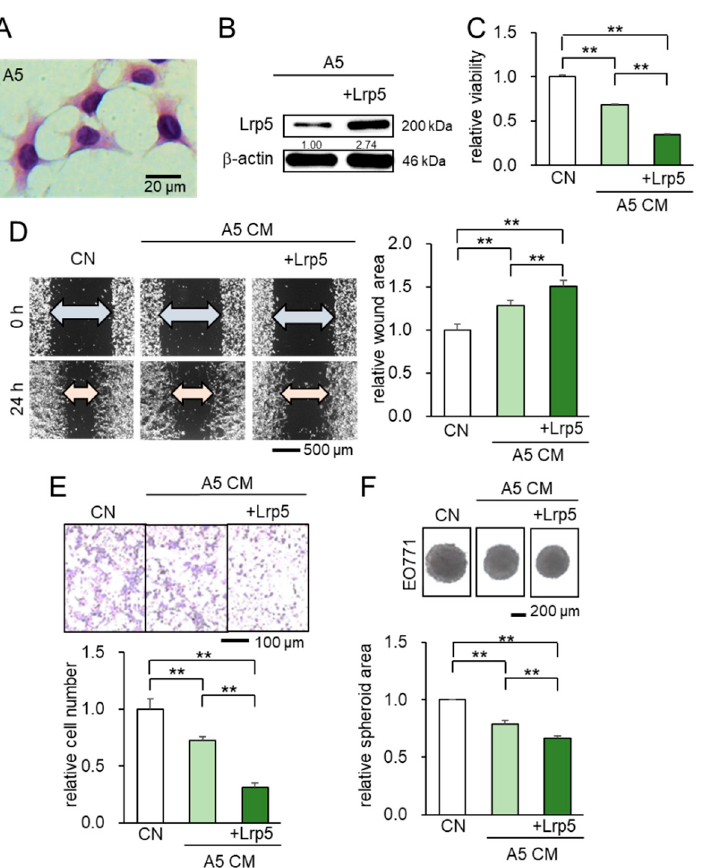
Figure 1. Suppression of the cellular proliferation, invasion, and migration in EO771 tumor cells by osteocyte-derived CM with and without Lrp5 overexpression. Of note, CN = control and CM = conditioned medium. The double asterisk indicates p < 0.01. The error bar indicates a standard deviation. ( A ) Representative images of MLO-A5 osteocytes (hematoxylin stained). ( B ) Transfection of Lrp5 plasmids in A5 osteocytes. ( C – E ) Reduction in MTT-based cellular viability, scratch-based migration, and Transwell invasion by osteocyte-derived CM. ( F ) Shrinkage of tumor spheroids in response to osteocyte-derived